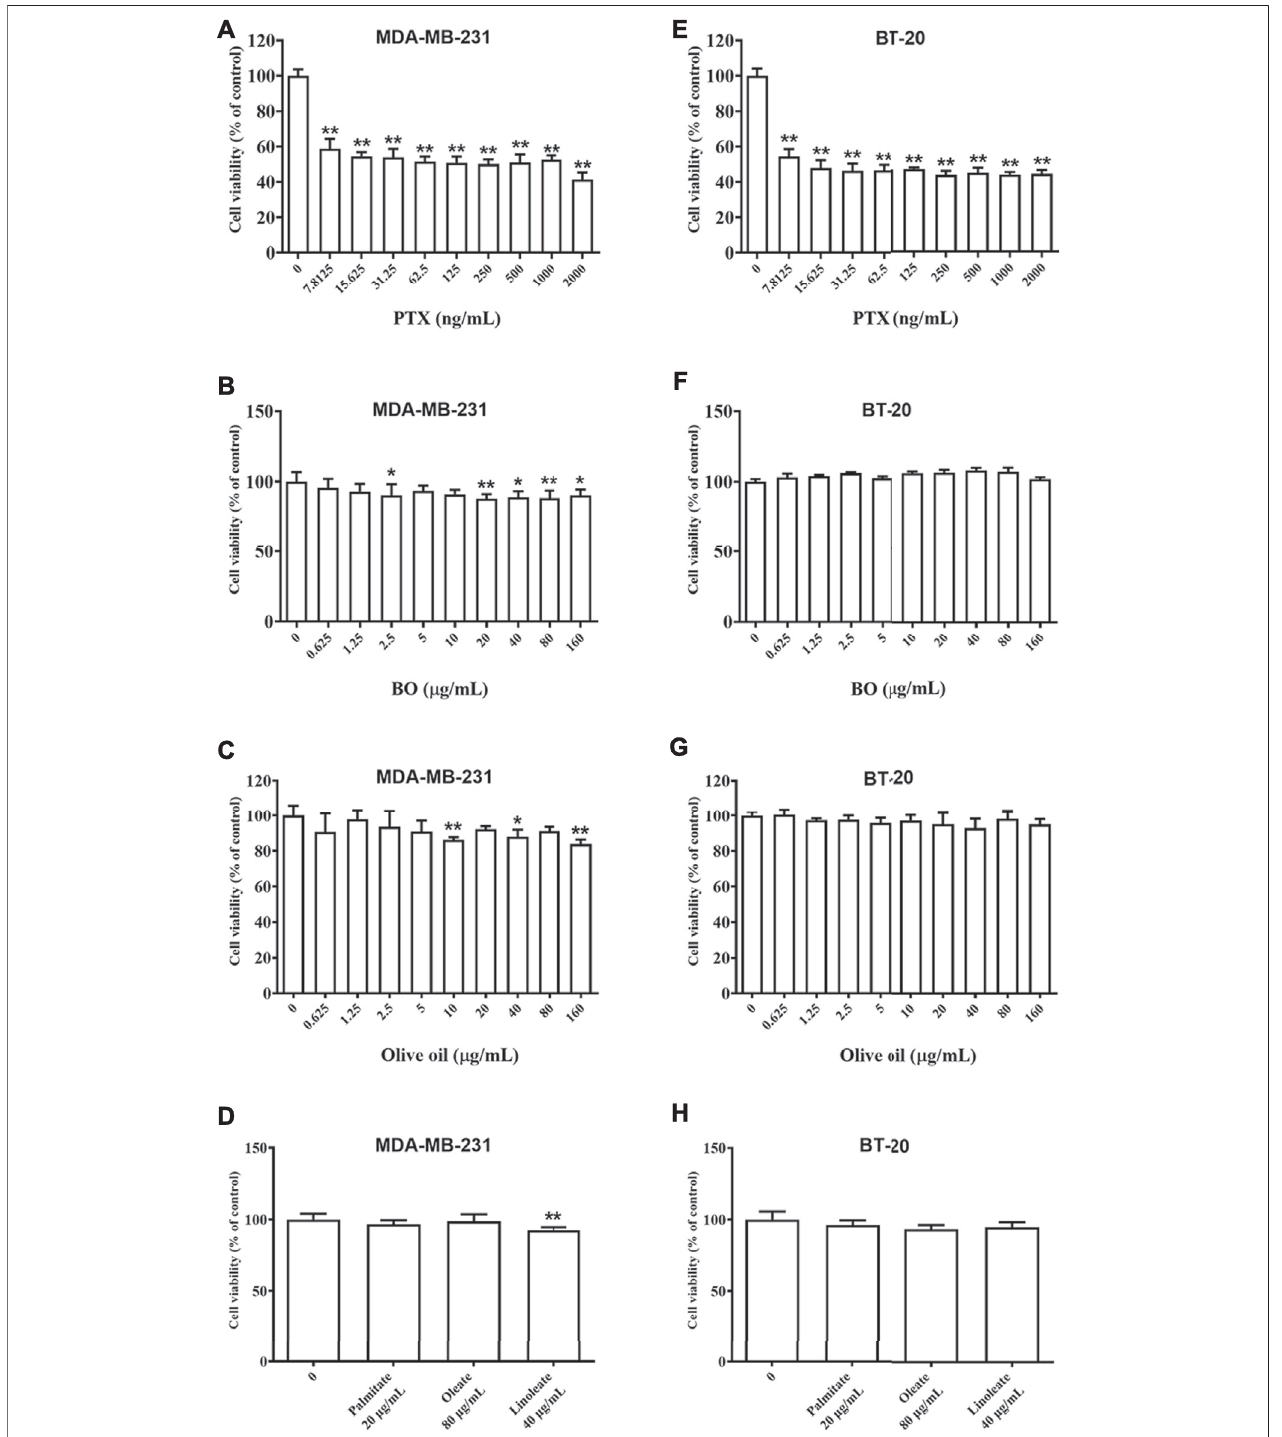
FIGURE 2 | Cell viabilities of MDA-MB-231 (A – D) and BT-20 (E – H ) are reduced by patclitaxel (PTX) but not affected by BO, olive oil, or the fatty acids (oleate, linoleate, palmitate). n (cid:2) 5. * p < 0.05 and ** p < 0.01.